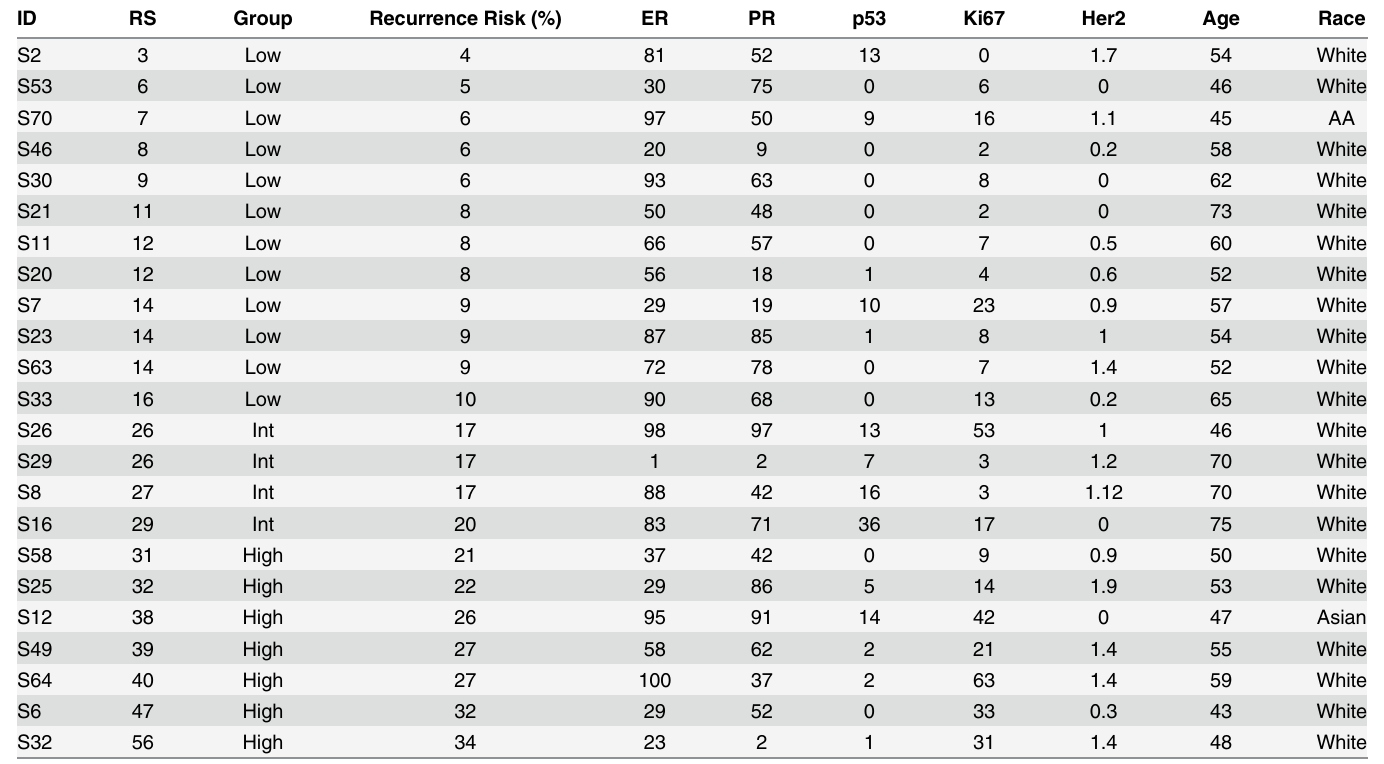
Table 1. Patient and tumor characteristics.